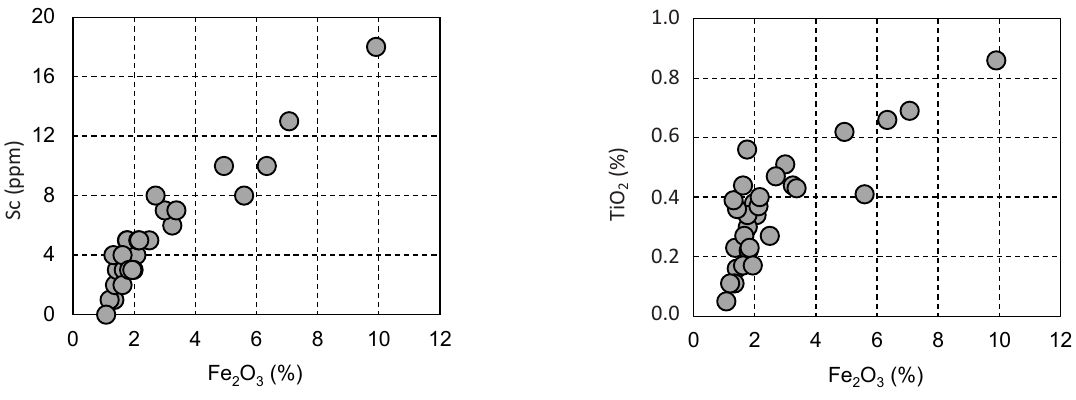
Fig. 7. Bivariate plots showing the Sc and TiO 2 contents versus the Fe 2 O 3 contents of